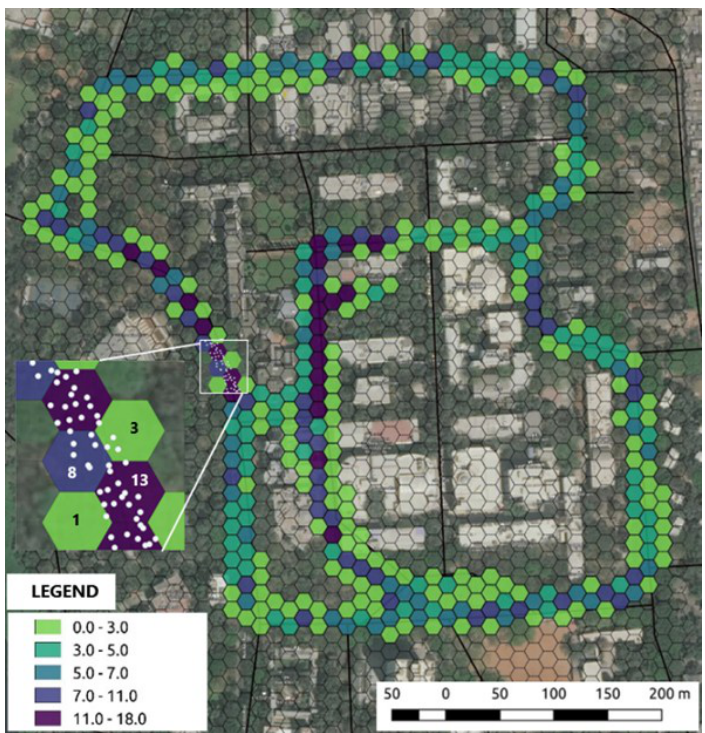
Figure 3. Map showing study area, data collection, and coverage. The zoomed-in area shows the location of observation points. Note: The legend represent number of observations.